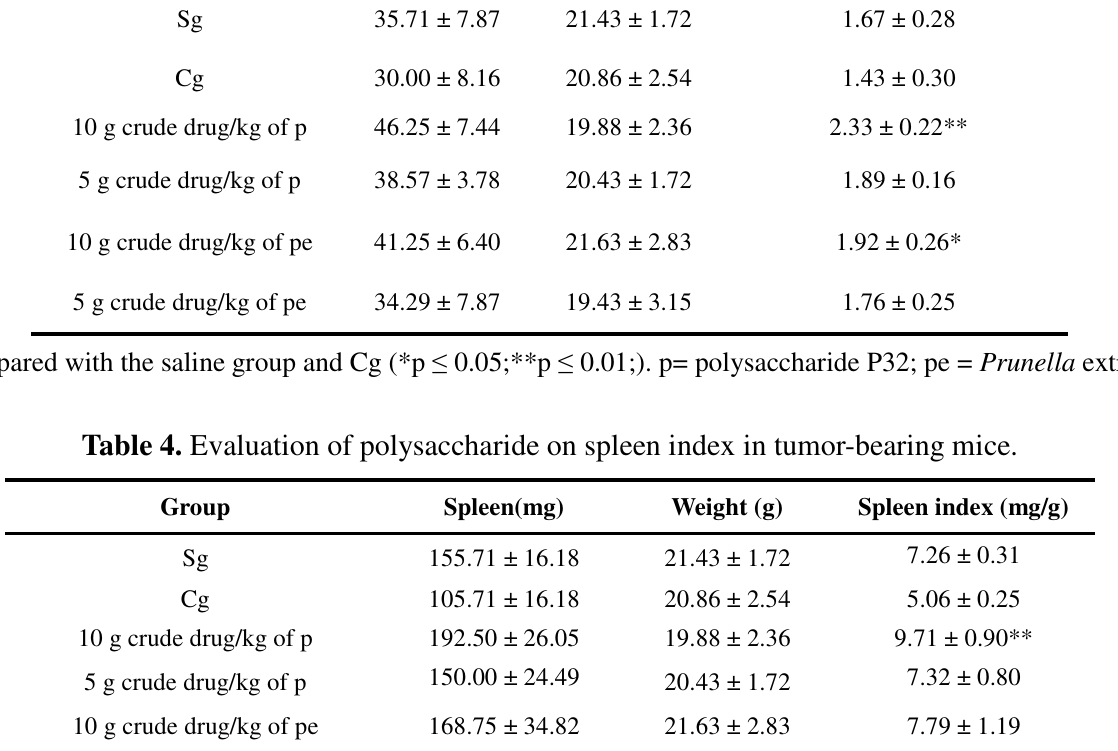
Table 3. Evaluation of polysaccharide on thymus index in tumor-bearing mice. Group